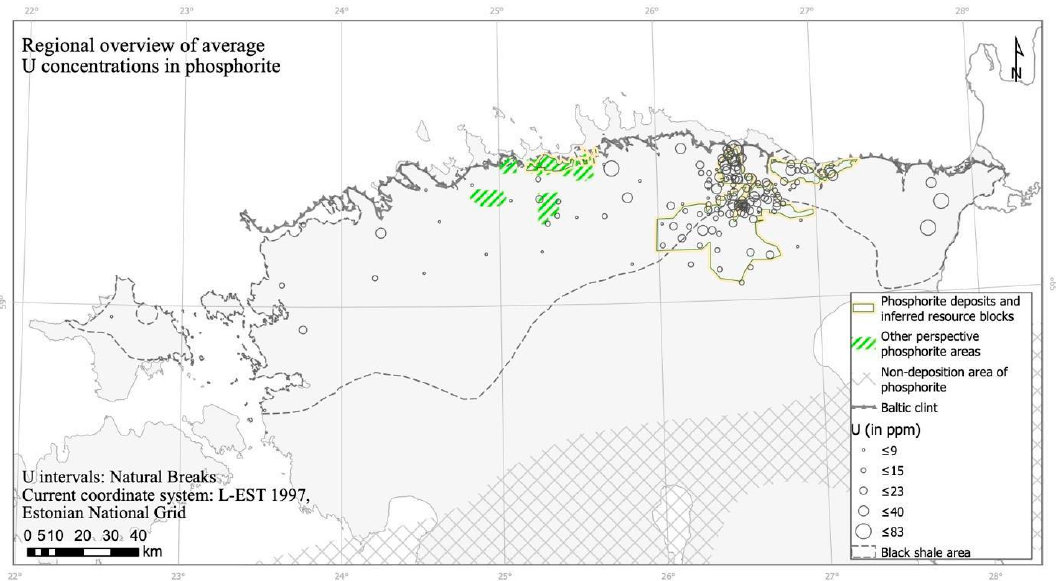
Figure 8. Regional overview of U concentrations in Northern Estonia.